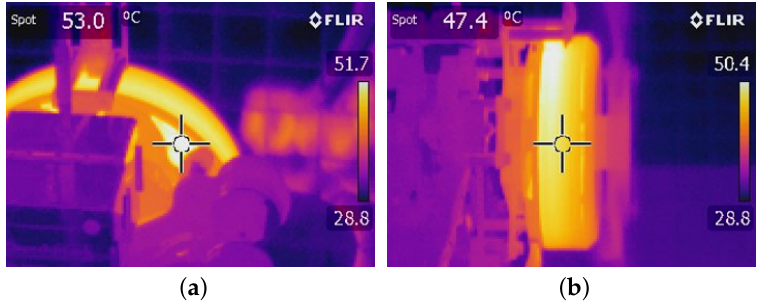
Figure 17. Thermal imaging for measuring motor temperature change: ( a ) Motor stator temperature ( ≈ θ con ), ( b ) Motor rotor temperature ( ≈ θ mag